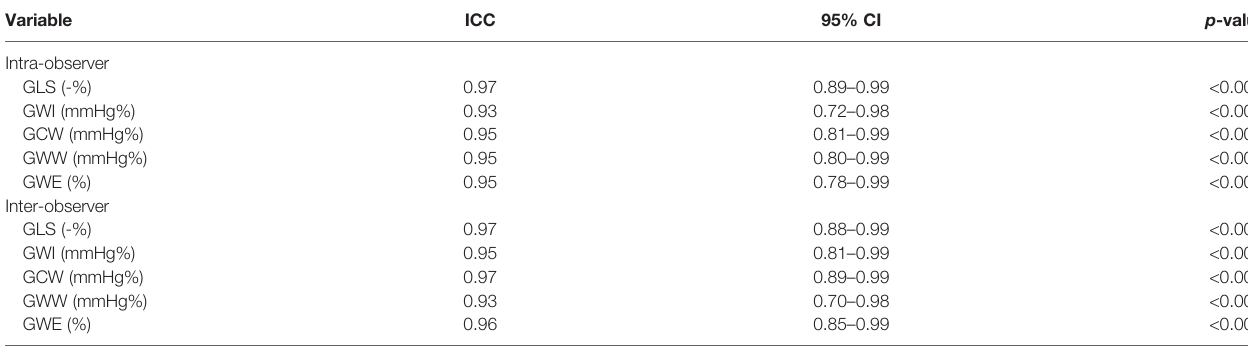
Values are intra-class correlation coef fi cient (ICC) with the 95% con fi dence interval (CI) and p-value. GCW, global constructive work; GLS, global longitudinal strain; GWE, global work ef fi ciency; GWI, global myocardial work index; GWW, global wasted